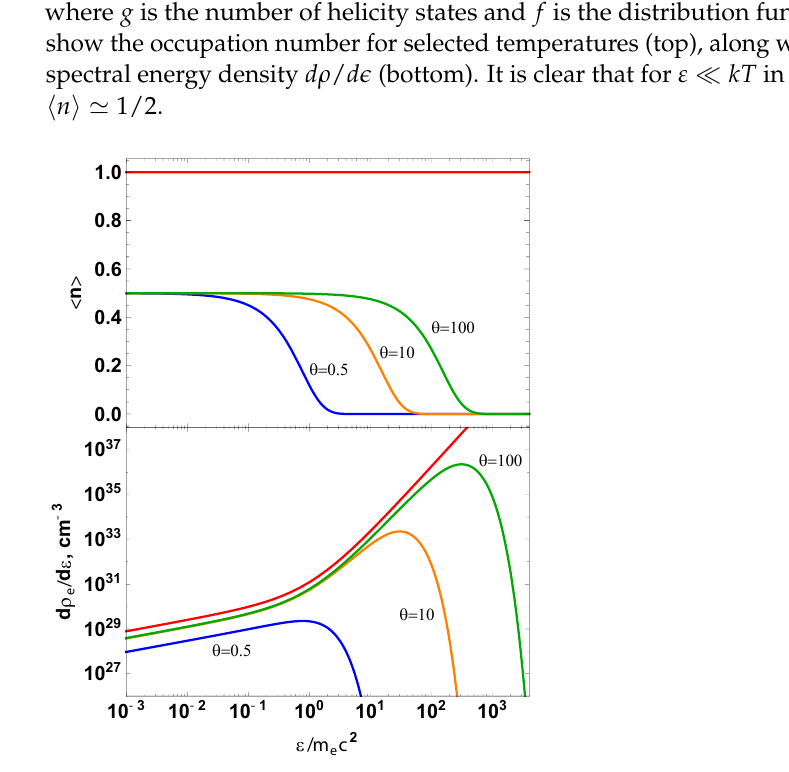
Figure 2. Thermal average occupation numbers (top) and thermal spectral energy density (bottom) of pairs as function of their kinetic energy for selected temperatures: θ = 0.5 (blue), θ = 10 (orange), θ = 100 (green). The limiting spectral density for pairs according to Pauli principle is shown in red. The amount of pairs in the relativistic regime becomes comparable to that of